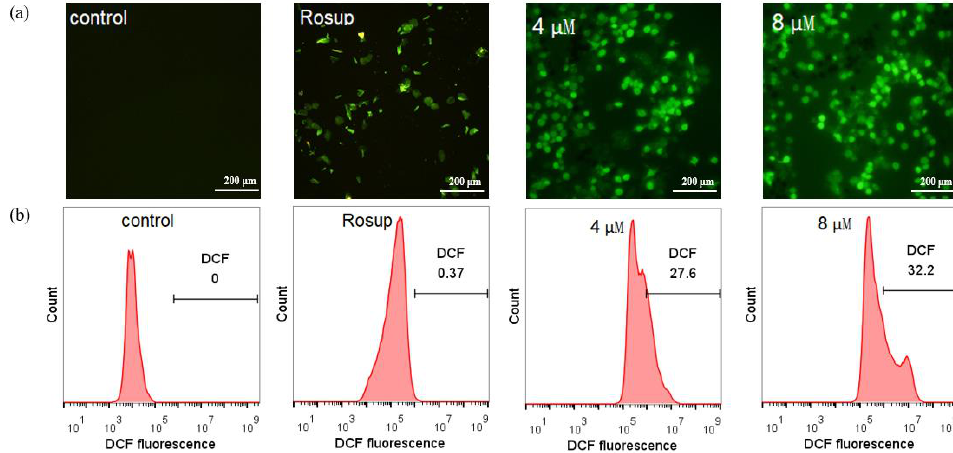
Figure 5. ( a ) Inverted fluorescence microscope and ( b ) flow cytometry detection for the ROS fluo- rescence changes of BGC-823 cells treated with 10f (0 μM, 4 μM, and 8 μM) for 24